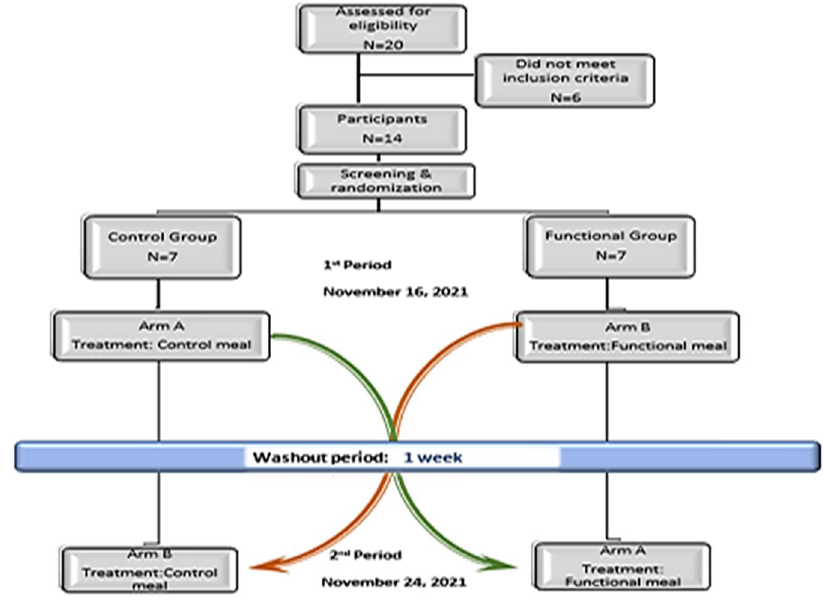
Figure 2. Study design illustration .